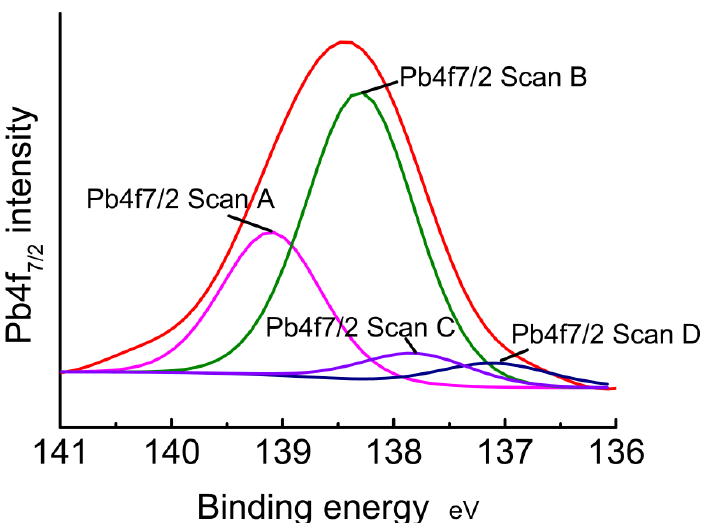
Figure 3. XPS narrow scan of the dolomite surface for samples after 15 d exposure to 1 mg/L PbCl 2 solution and the Pb4f 7/2 peak was split and fitted. The red line is the fitted line; Scan A: PbSO 4 ; Scan B: PbCO 3 ; Scan C: PbO; Scan D: PbS. Table 1. Binding energy (BE), full width at half-maximum (FWHM), and chemical state for pure Pb compounds in XPS